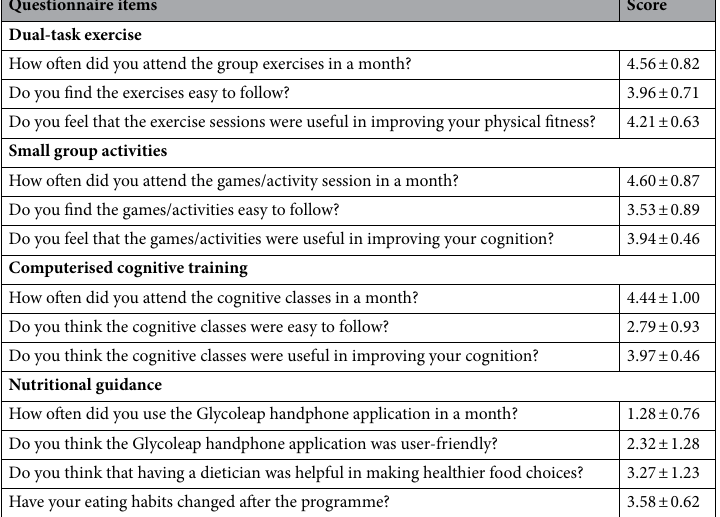
Table 6. Responses from IG participant questionnaire (n = 70) [maximum score of 5]. Data presented in mean ± SD. Questions were based on 5-point Likert scale where lower scores indicate negative responses and higher scores indicate positive